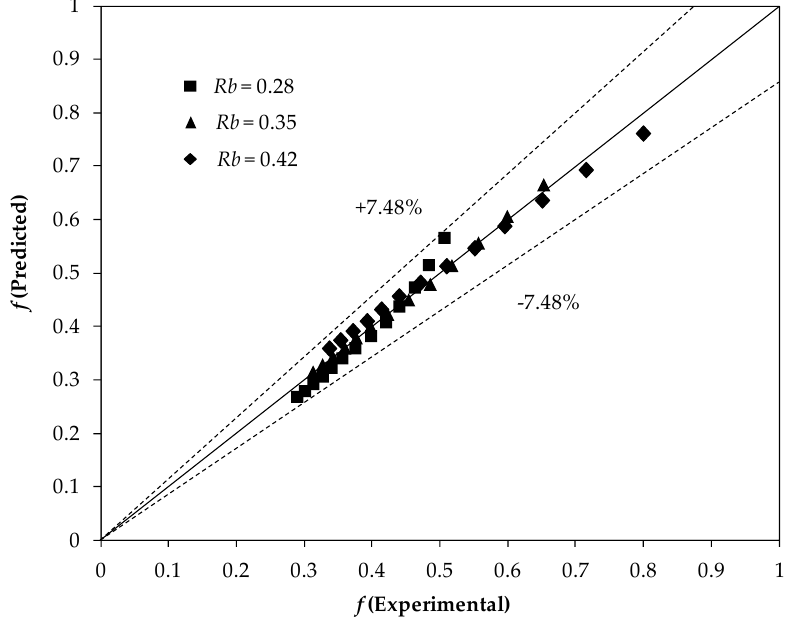
Figure 10. Comparison between the experimental f with predicted f .